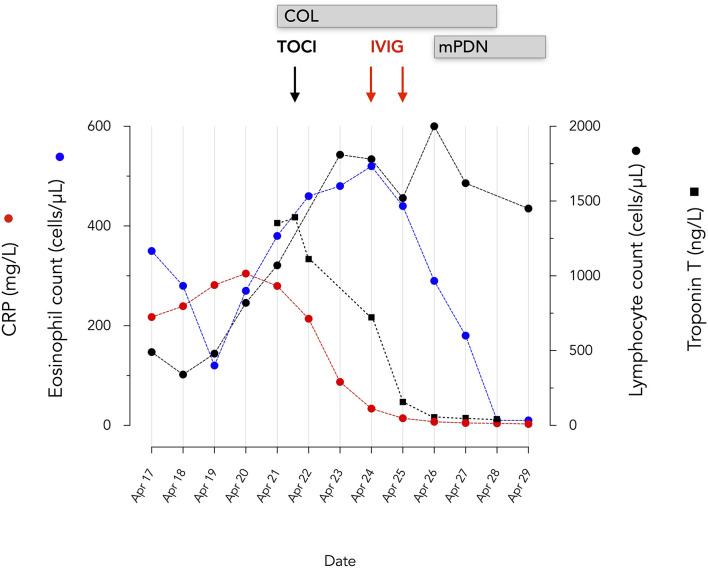
Evolution of eosinophils, lymphocytes, serum CRP and troponin T. mPDN, methyprednisolone 60 mg IV bid initially, 48 mg oral dose at discharge; 24 mg at May 14; COL, Colchicine 0.5 mg bid; TOCI, tocilizumab IV 480 mg; IVIG, Privigen 60 g.